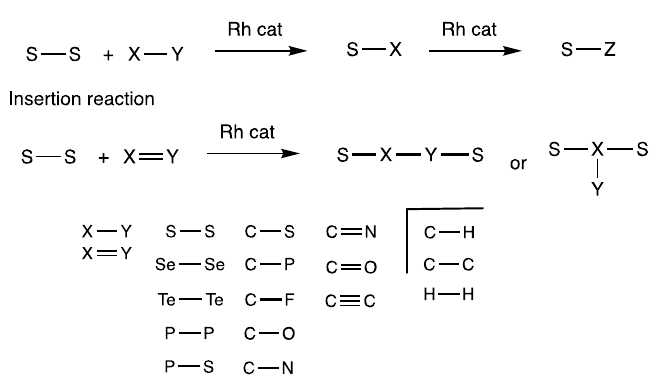
Figure 2. Diverse reactivity of substitution and insertion reactions of the S-S bond in disulfides with various other chemical bonds.